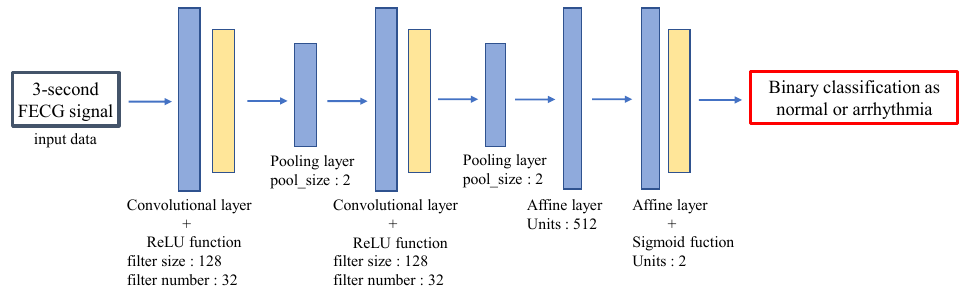
Figure 3. The structure of CNN model in the proposed method including layers, each parameter value, and input/output